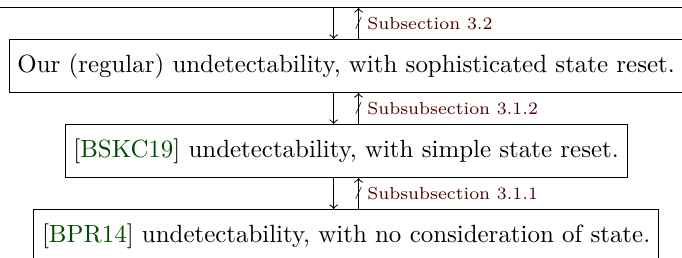
Figure 3: Relationships between detectability games in other works and ours. Arrows indicate that if an ASA is undetectable in the game at the tail of the arrow, then it is also undetectable in the game at the head of the arrow. Crossed arrows indicate that there exists an ASA undetectable in the game at the tail of the arrow but detectable at the head of the